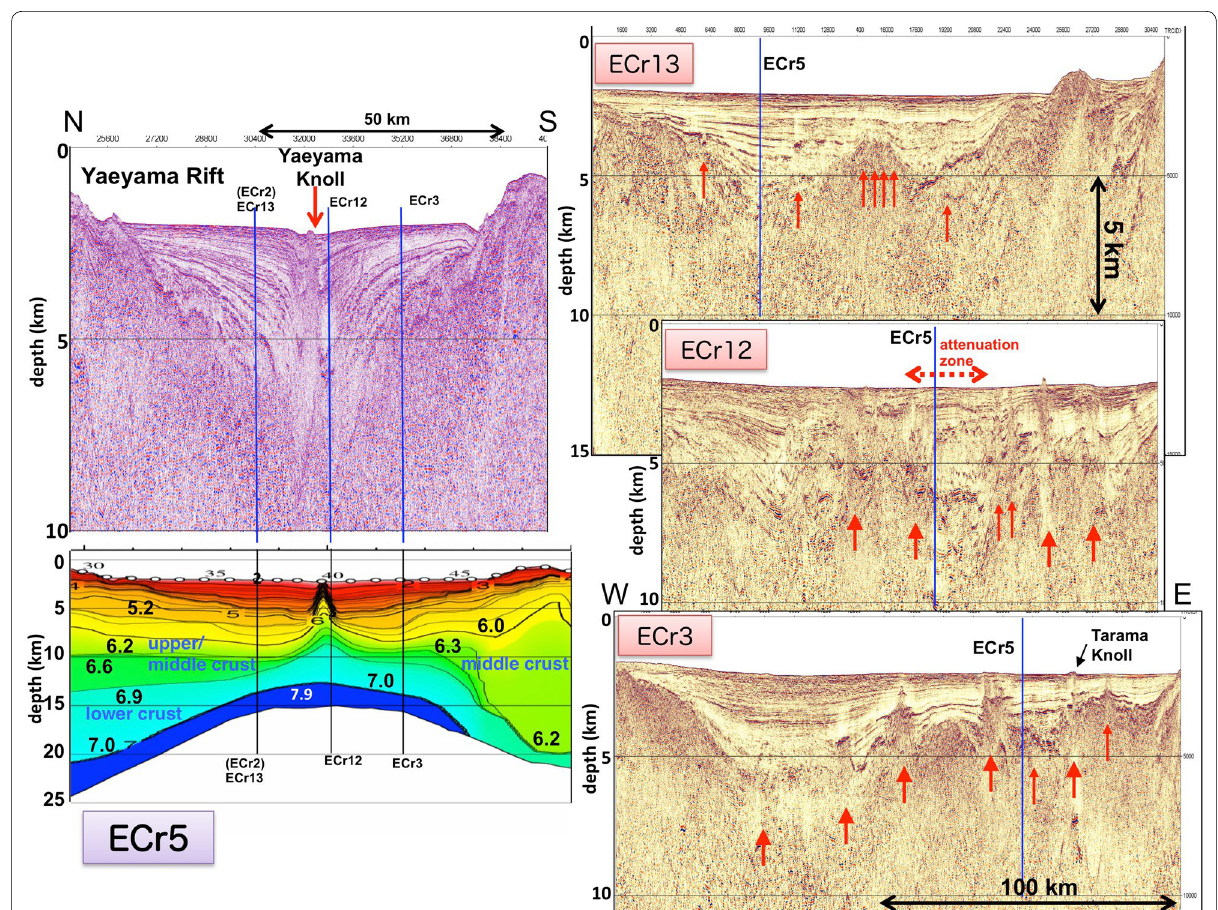
Fig. 17 Comparison of the MCS profiles (depth section) perpendicular and parallel to the Yaeyama Rift. Left: Across-rift line ECr5. V p model around the rift is also shown. Right: MCS depth profiles for rift-parallel lines of ECr13, ECr12, and ECr3. Noticeable volcanic intrusions are shown by up-arrows. Smaller arrows indicate small-scale intrusions. More and larger intrusions were detected along ECr13 compared with ECr3, indicating an asymmetric seismic structure across the rift